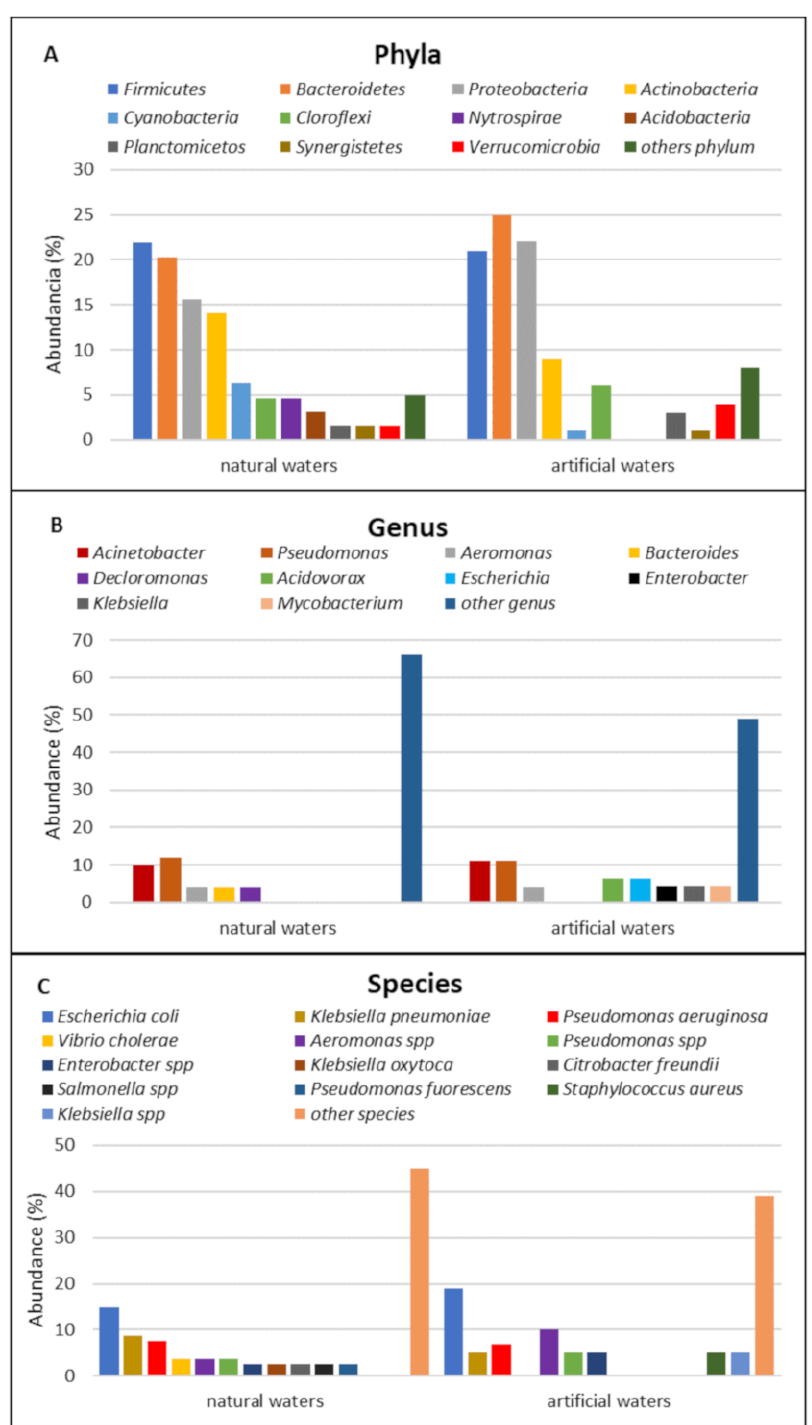
Figure 4. Taxa detected in the articles included in this systematic review. ( A ) Phyla, ( B ) Genus, ( C )